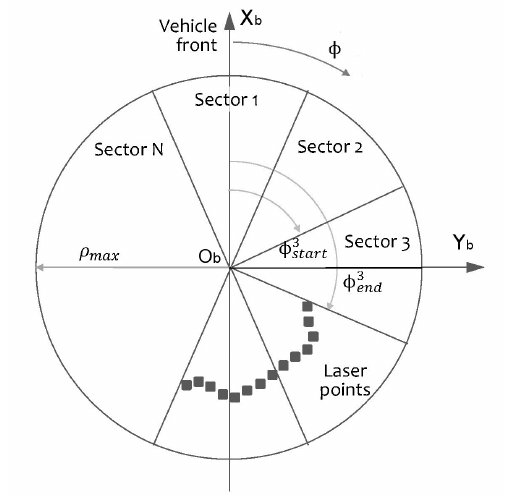
Figure 2. Constant angle sectors for obstacle